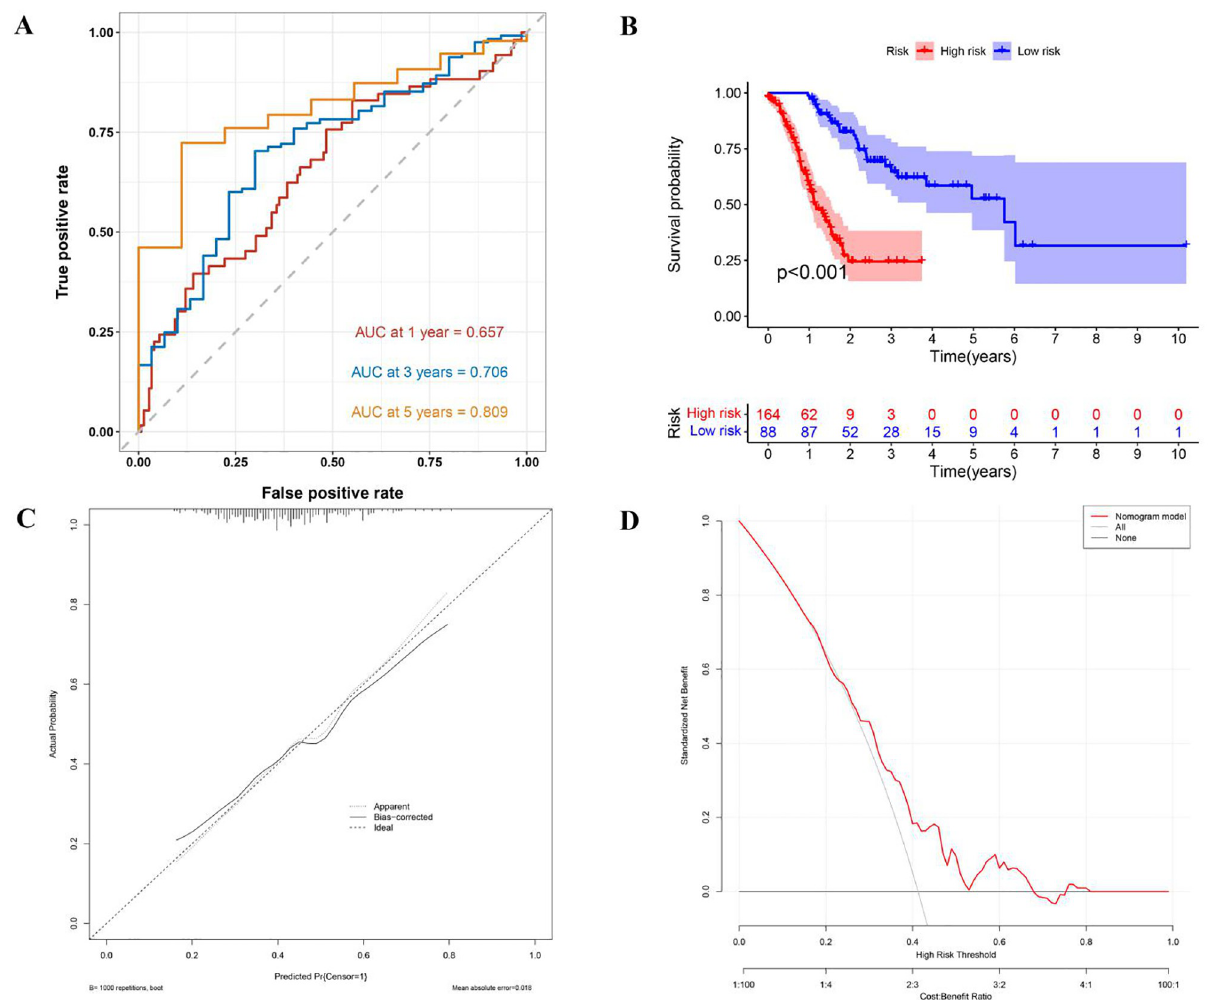
Fig 7. ROC curves, survival curves, calibration, and decision curve analysis for the TCGA data set. ROC curves for 3, 5 and 10 year projections of the line graph model. (B) In the validation set, the high-risk group was associated with worse survival outcomes, P < 0.001. (C) Calibration curves for the survival probability of the column line graph model. (D) The DCA curve was used to evaluate the clinical utility of the nomogram model decision